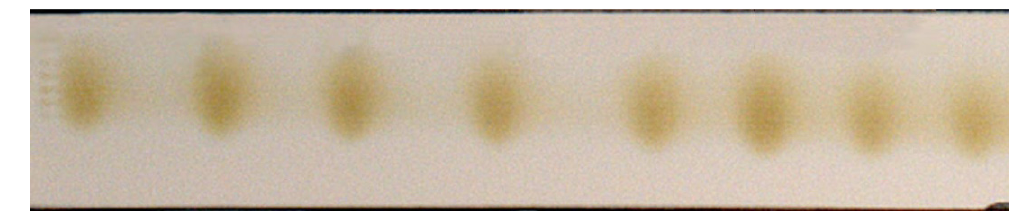
Figure 3. Visualization of the DART gas beam focus on a 10-cm long TLC plate strip, recorded in the scanning mode and showing the misalignment of a TLC strip at the self-built x -table for TLC-DART-MS (reproduced from [20], with permission of ‘John Wiley and Sons’). Automated scanning TLC/HPTLC-DART- MS with potential for quantitation and Imaging